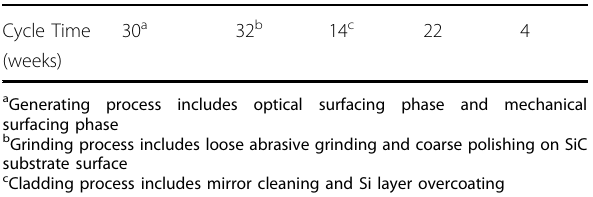
Table 1 Allocated cycle time in manufacturing the ⌀ 4.03 m SiC aspheric mirror Process